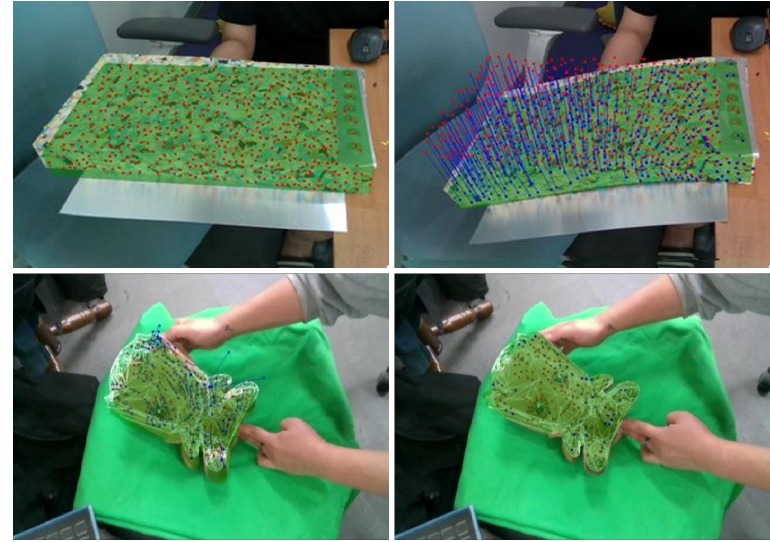
Figure 1. Soft-body deformation of observed